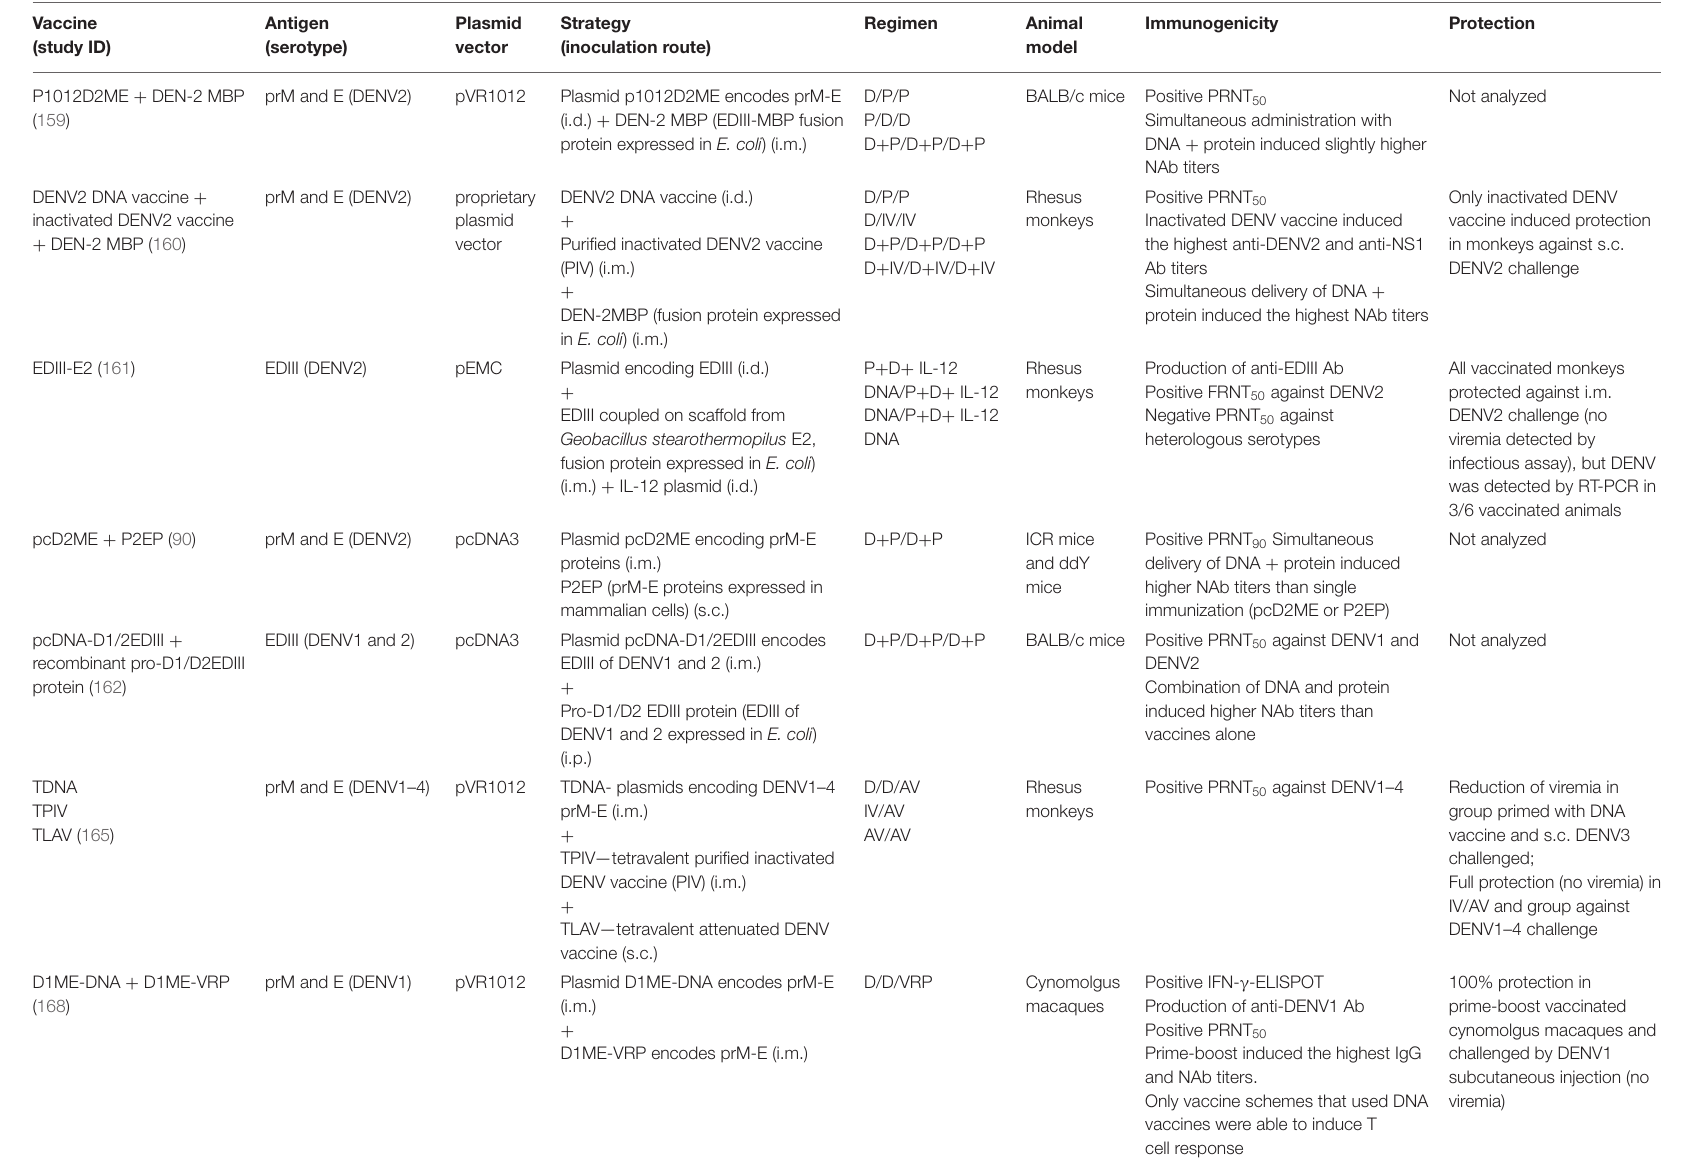
TABLE 4 | Heterologous prime/boost strategies in dengue DNA